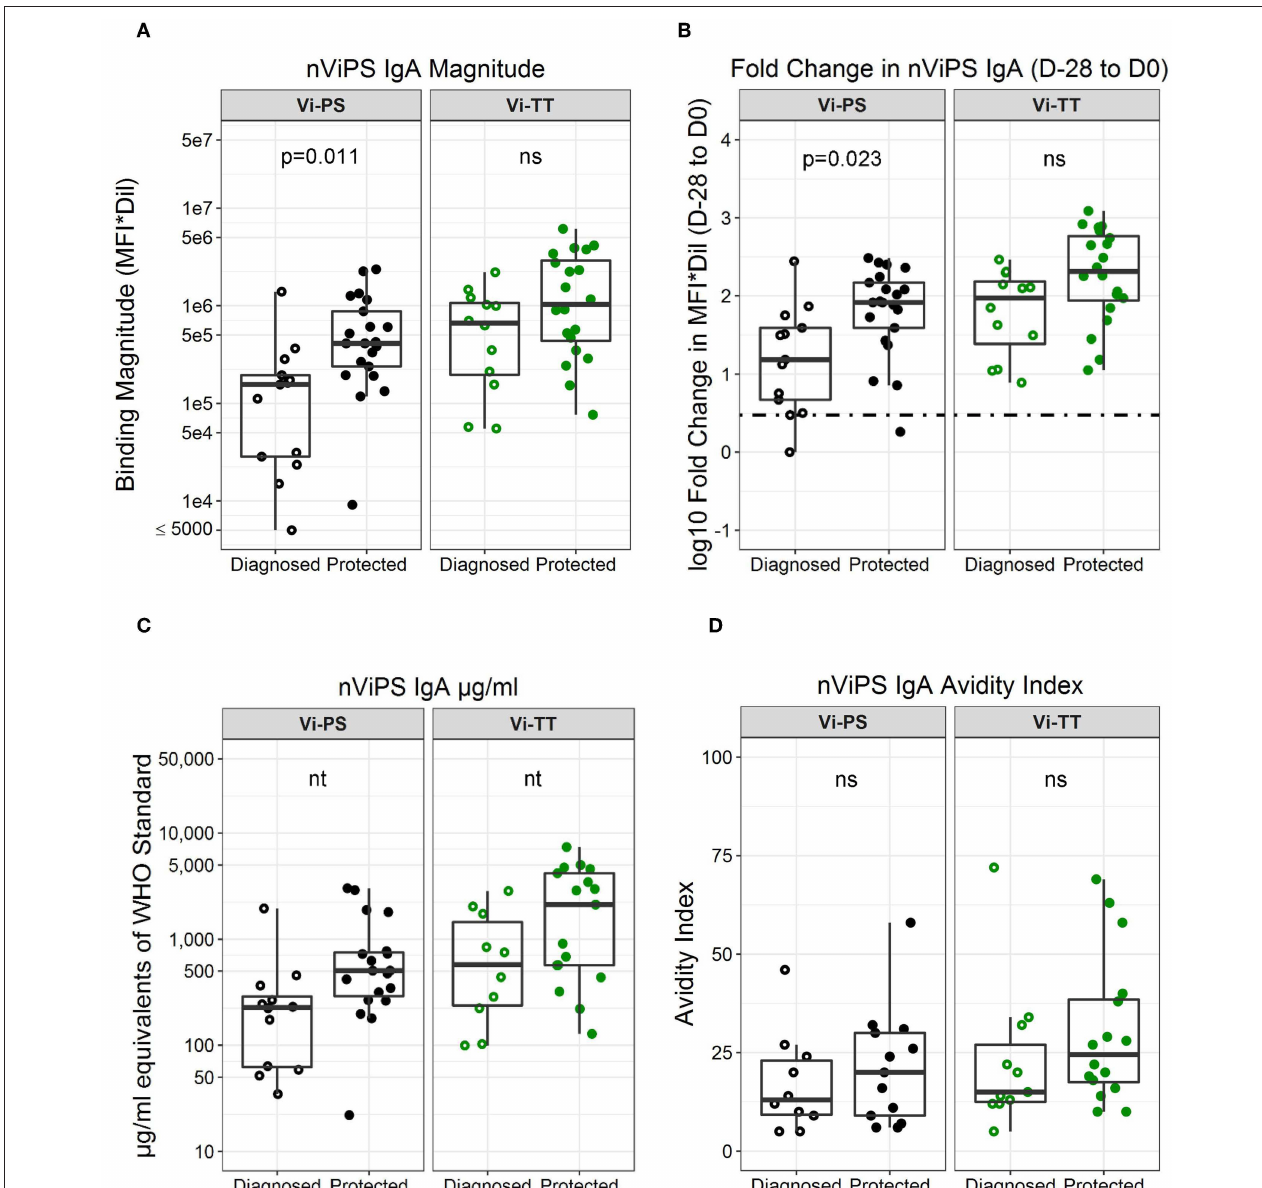
FIGURE 3 | nViPS-specific total IgA magnitude, fold change, and avidity higher in protected individuals of both vaccine groups. nViPS-specific IgA magnitude (A) fold change (B) µ g/mL equivalents of WHO typhoid IS 16/138 (C) and avidity index (D) by diagnosed/protected outcome at day of challenge. Data points are representative of n = 2 independent experiments (each with n = 2 technical replicates). n.s indicates non-significant FDR-corrected p values. nt indicates not tested for statistical